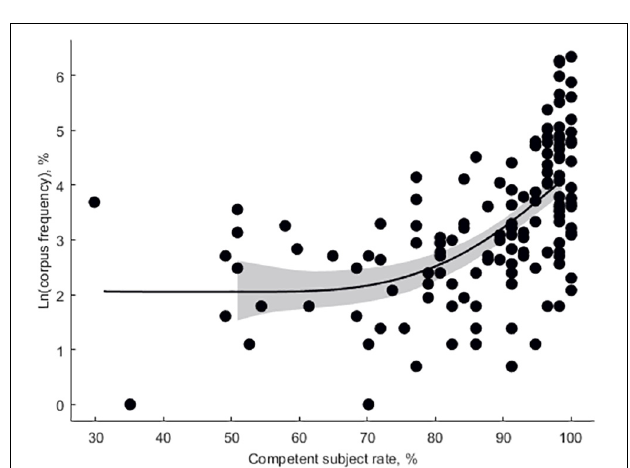
FIGURE 6 | The percent of conflict effect rate from the Attention Network Task (ANT) as a function of error rate in vocabulary proficiency task (Eilers